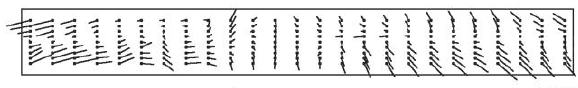
Figure 12. Correction grid forward camera, image F61